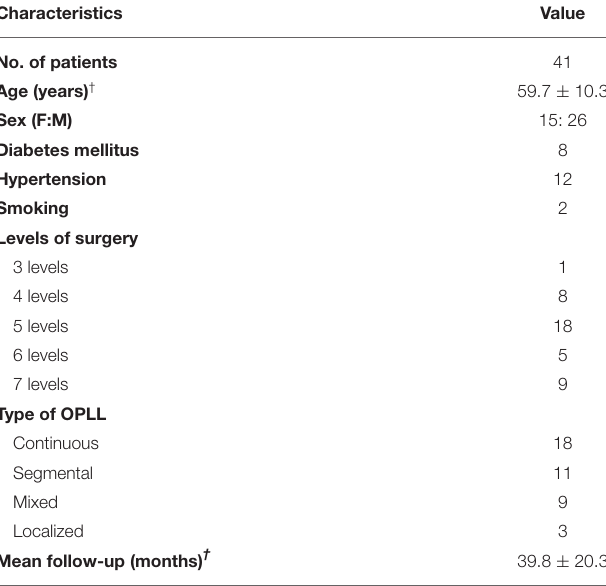
TABLE 1 | Demography of the OPLL